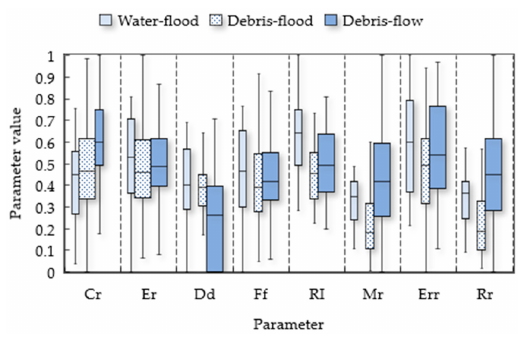
Figure 5. Boxplot of the Min-Max normalized parameters grouped by the DFP